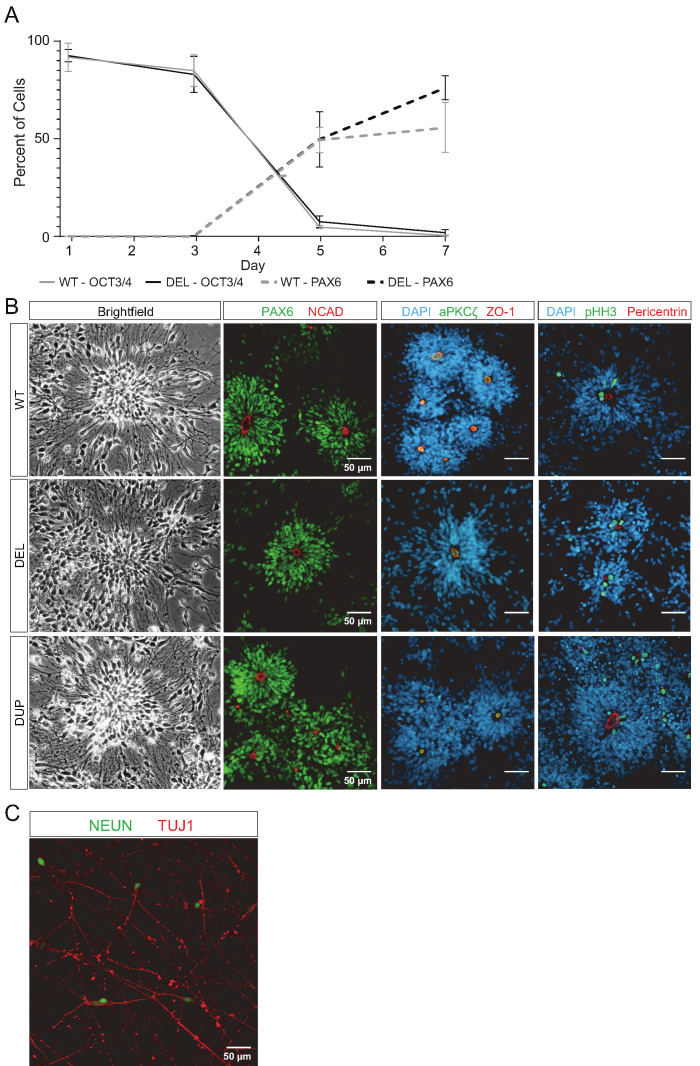
hiPSCs differentiate into NPCs and neurons.(A) Flow cytometric analysis of the transition between OCT4+ pluripotent hiPSCs and early PAX6+ telencephalic neural progenitor cells. Error bars represent the SEM. Replicates were as follows: WT (3 clones from two donors), DEL (6 clones from three donors). (B) Wild-type (WT), 16p11.2 microdeletion (DEL), and 16p11.2 microduplication (DUP) Day 26 neural rosettes show the typical radially arrayed clusters of neural progenitor cells in brightfield micrographs. Clone IDs for each image: DEL (DEL_5_9, DEL_1_2, DEL_5_8, DEL_9_984), DUP (DUP_3_1, DUP_1_9, DUP_3_3, DUP_1_8), WT (WT_8343.2, WT_8343.2, WT_8343.4, WT_2242.5). (C) Day 45 immature neurons are characterized by long neurites and expression of the neuronal markers TUJ1 and NEUN (scale bar, 50 µm). Clone WT_8343.5.